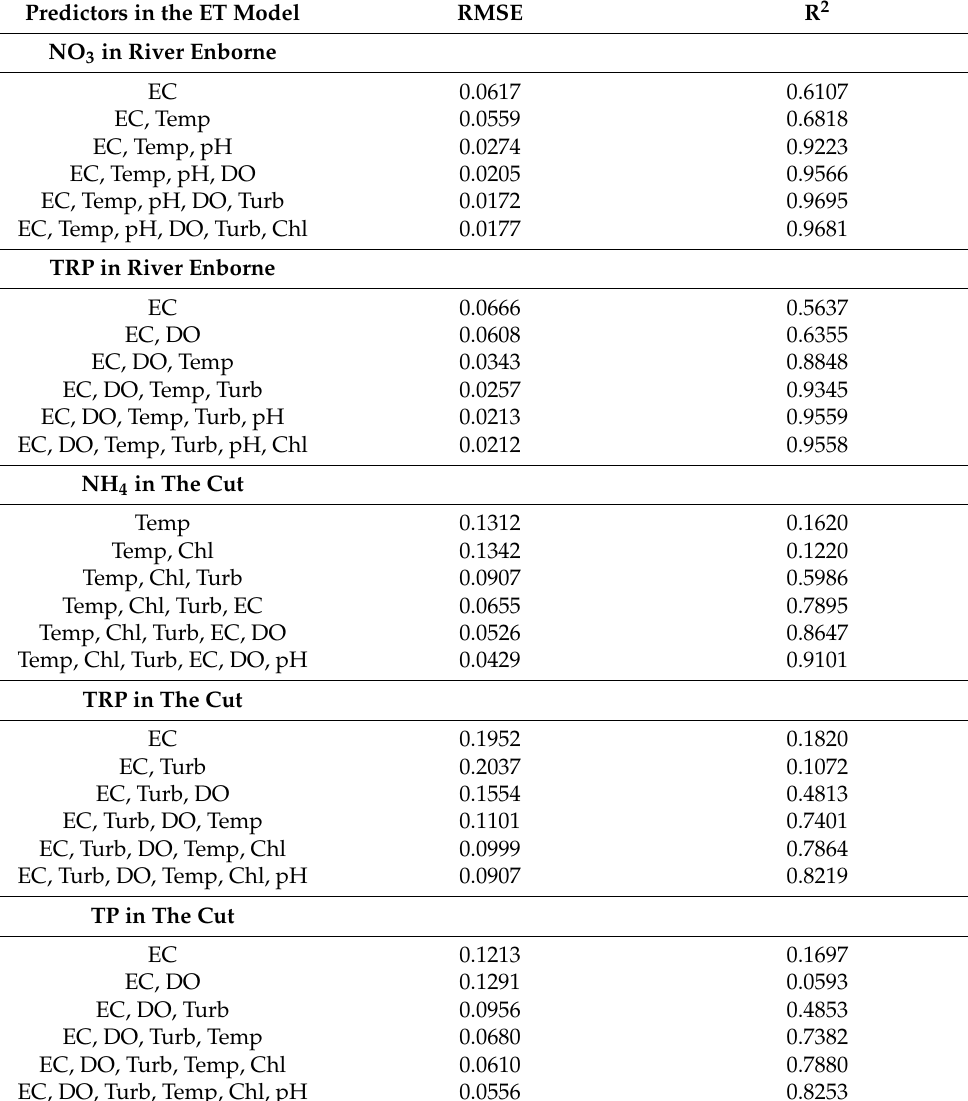
Table 10. Predictive performance of the ET model as a function of each predictor’s contribution. Predictors in the ET